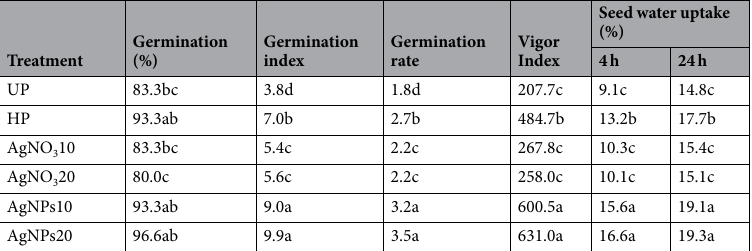
(Table 1). Nanoprimed seeds (both AgNPs10 and AgNPs20) imbibed water faster than other primed groups at the very beginning (4 h) of imbibition ( p < 0.05). At 24 h, seed water uptake of nanopriming treatment was still higher than hydropriming and AgNO 3 priming treatments.